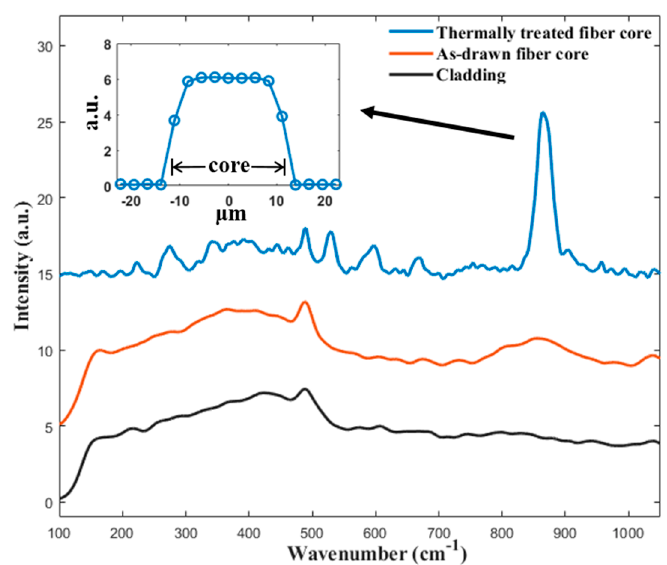
Figure 4. Raman spectra of the fabricated BTS fiber before and after the thermal heat treatment. The insert shows the line scan profile of the peak strength at 865 cm − 1 across a thermally heat-treated fiber core.